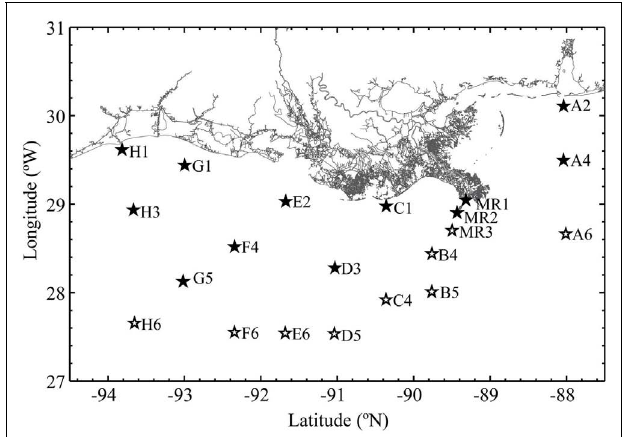
FIGURE 1 | Stations occupied during the GulfCarbon 5 cruise, March 10–21, 2010. Inshore stations represented with a filled star; offshore stations have an open